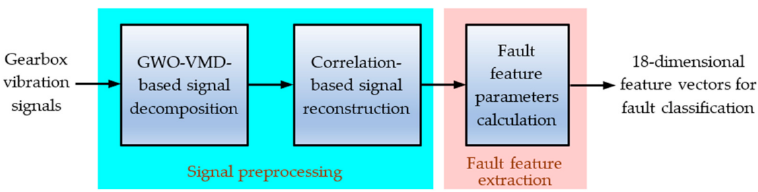
Figure 1. Workflow of vibration signal preprocessing and feature